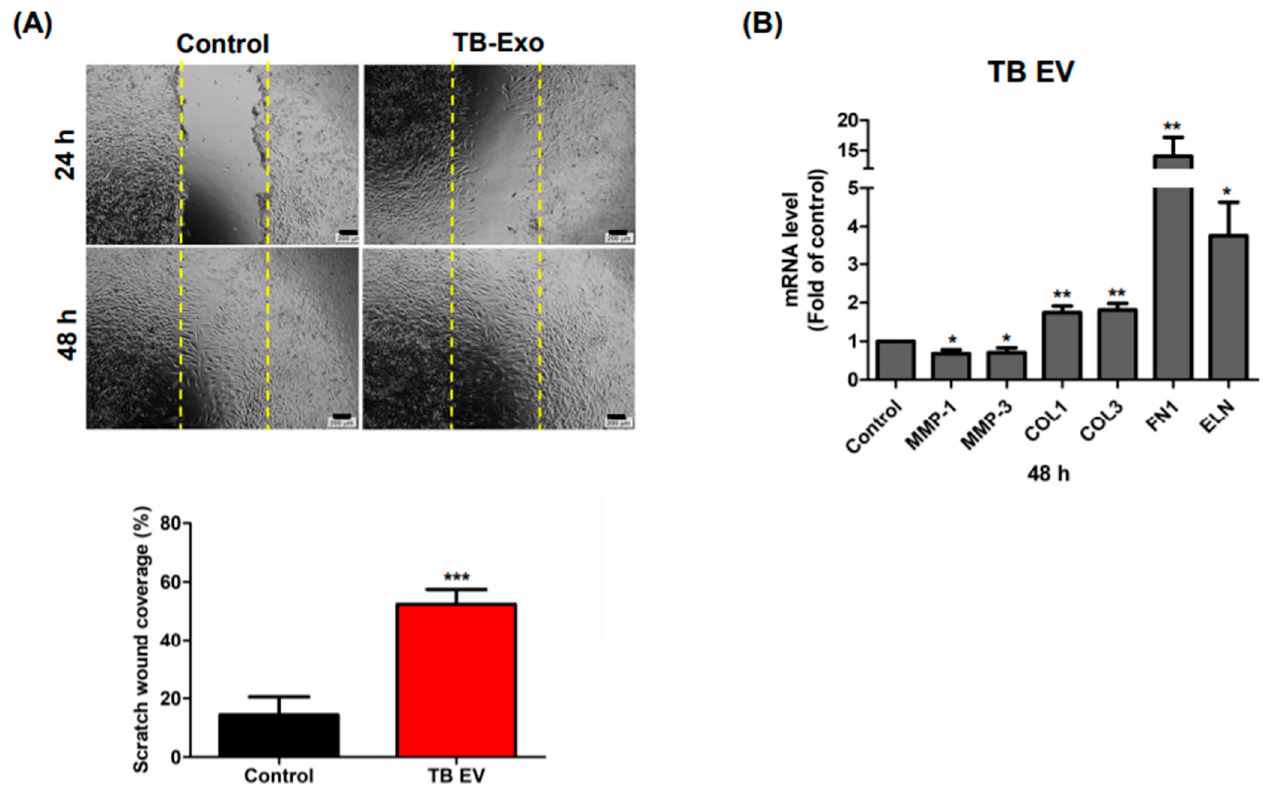
Figure 3. TB-Exos induced migration of HNDFs. ( A ) Scratch-wounded HNDF cells were treated with 1 × 10 5 particles/mL of TB-Exos for 24 and 48 h, followed by the determination of the area of cell migration using ImageJ. Scale bar: 200 μ m. ( B ) Quantitative RT-PCR method was used to analyze the relative expression levels of genes encoding for MMP-1, MMP-3, collagen type I, fibronectin 1, and elastin in TB-Exo-treated scratch-wounded HNDFs. Data are represented as means and SD; * p < 0.05, ** p < 0.01, and *** p < 0.001, as compared to the control.